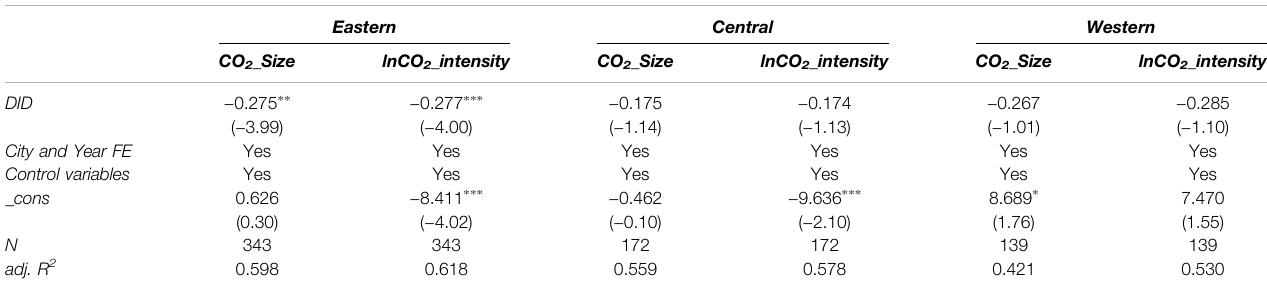
TABLE 6 | Spatial heterogeneity.